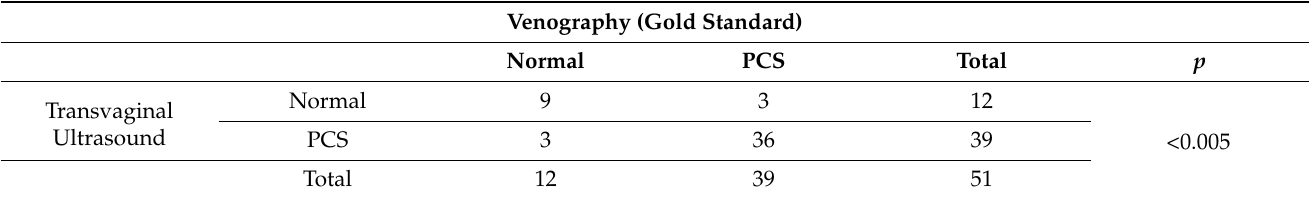
Table 4. Evaluation of the transvaginal ultrasound diagnostic accuracy of pelvic congestion syndrome using the criteria of any pelvic vein diameter of 8 mm or